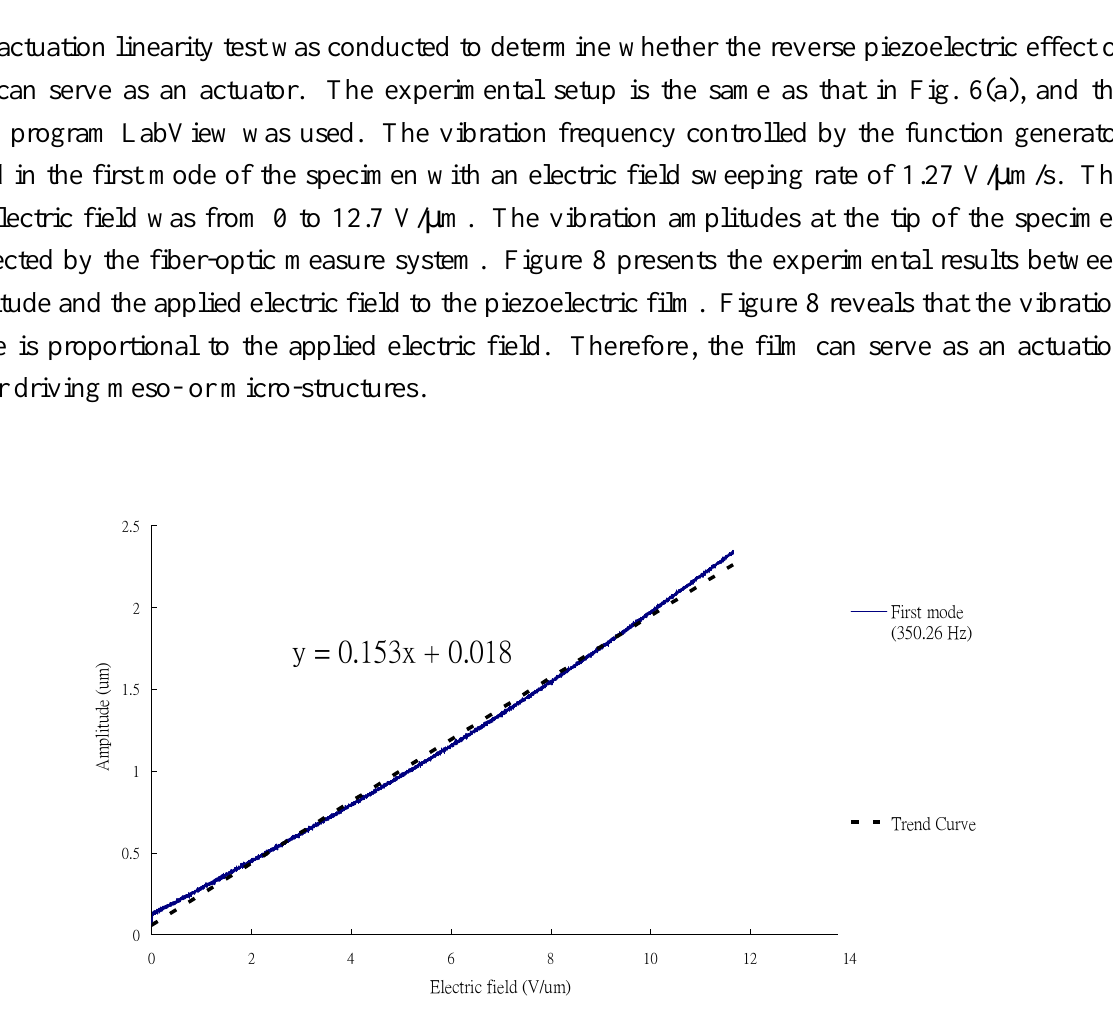
Figure 7. Actuation tests of the 6.5 µ m-thick PZT film in the first bending mode, using the oscilloscope (CH1: excitation from the function generator; CH2: driving voltage divided by 20; CH4: vibration signal detected by the photonic sensor).